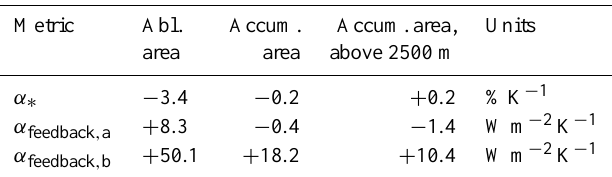
Table 3. Magnitude of albedo-temperature sensitivity and net short- wave flux (insolation) feedback for different ice sheet surface mass balance